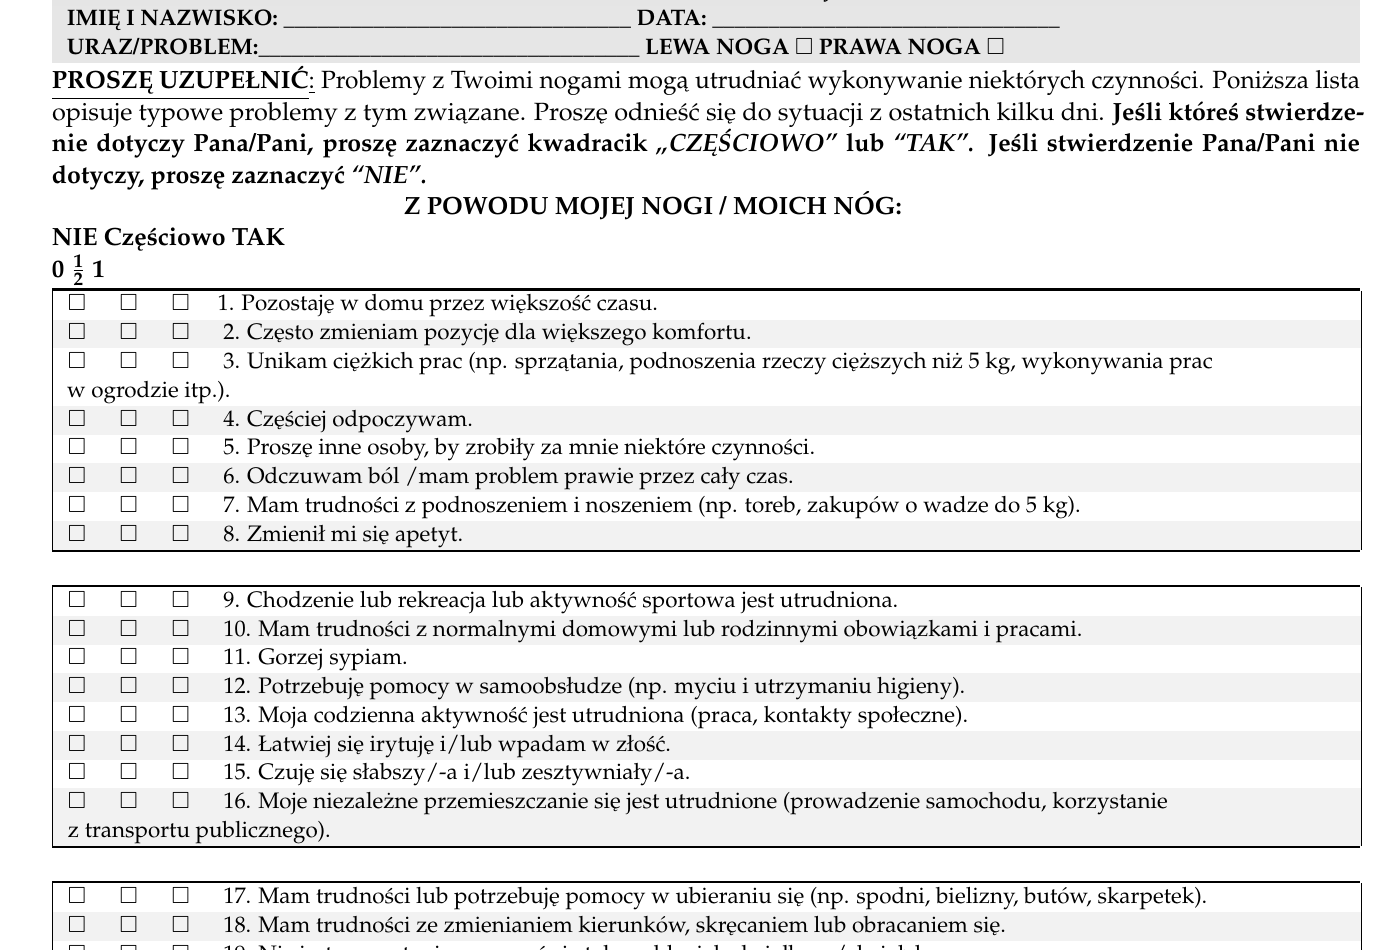
LOWER LIMB FUNCTIONAL INDEX—WERSJA POLSKA